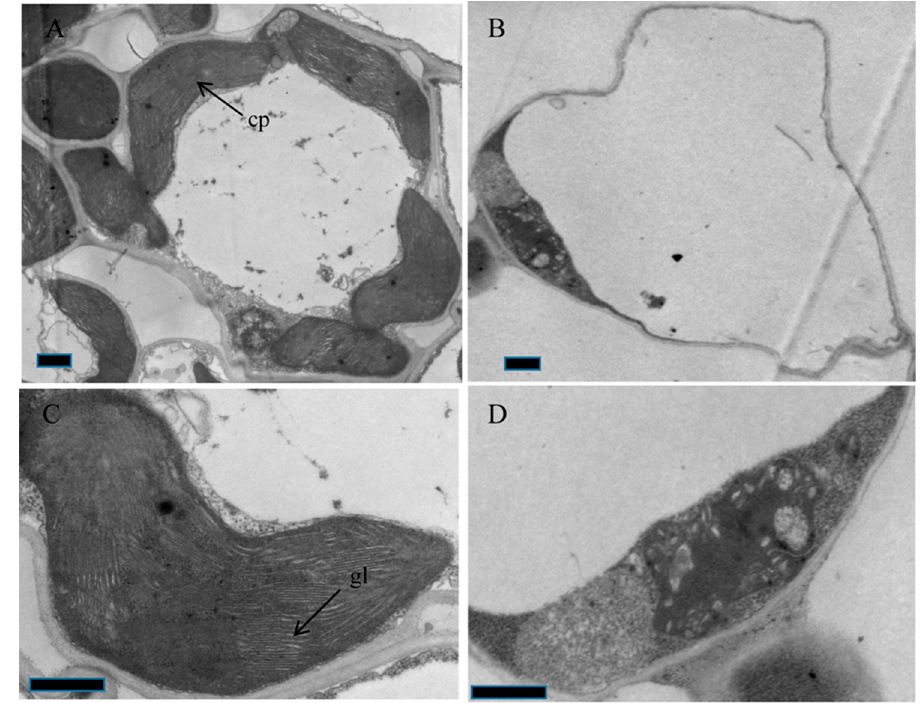
Figure 3. Chloroplast ultrastructure observation of WT ( A , C ) and oscaf1 mutants ( B , D ) mesophyll cell at the three leaves stage. cp, chloroplast, gl, grana lamella. Bars = 2.0 μ m.